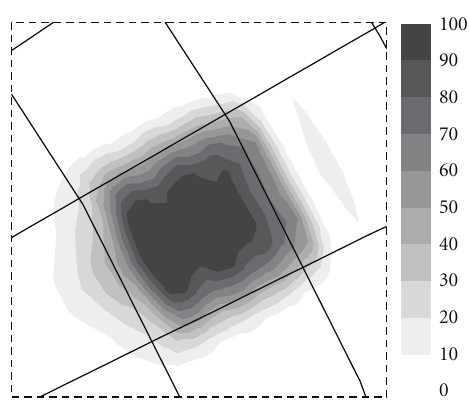
Figure 9: Map of the retrieved reflector surface for a deformation of 100 μ m of the panel under test. SNR = 40 dB. The color bar is in unit of μ m.